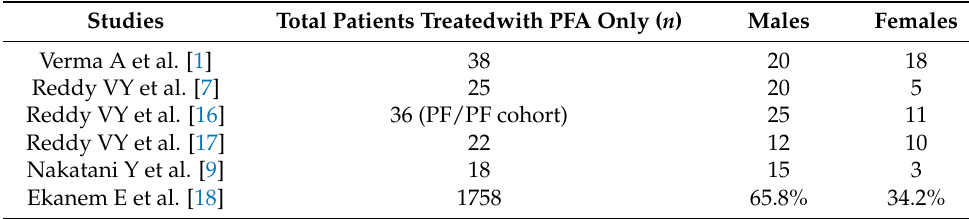
Table 1. Number of participants in included